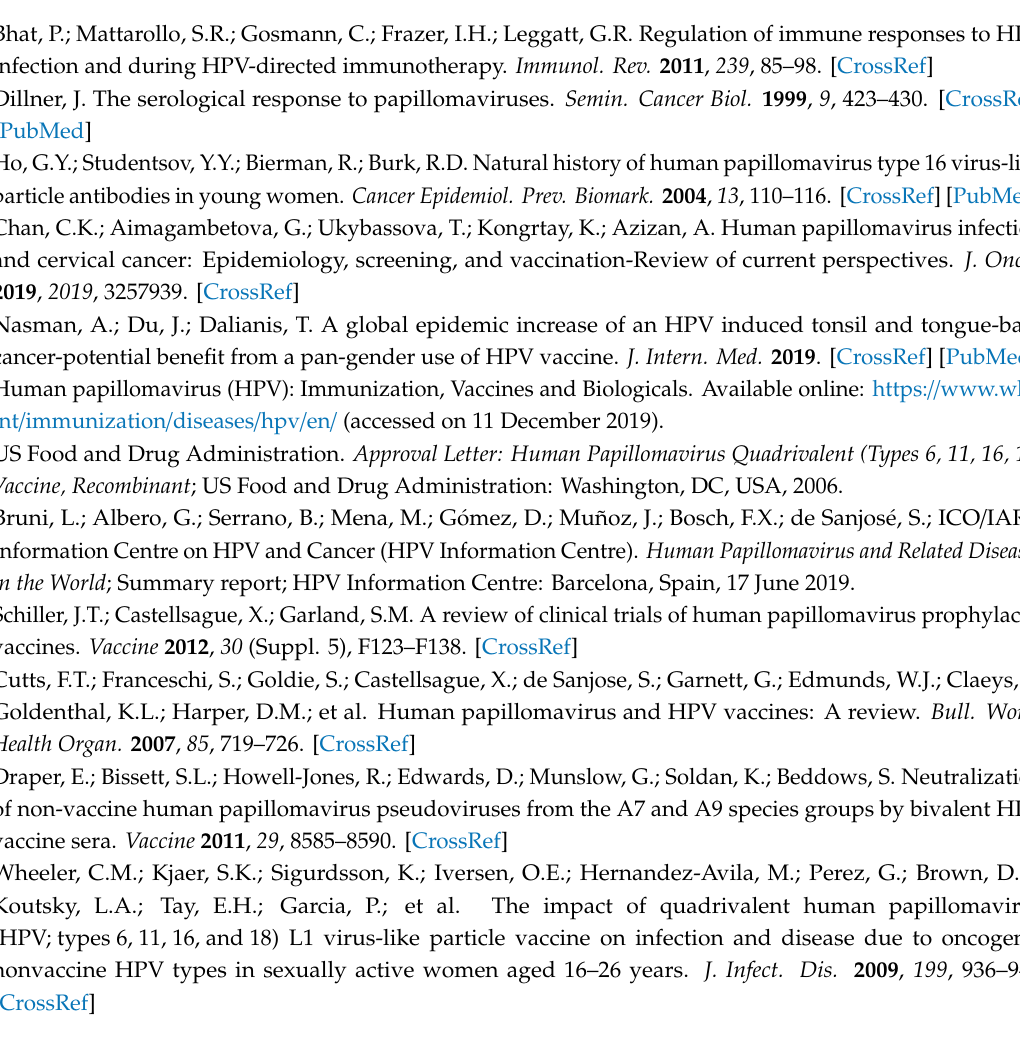
Figure S1: B cell Elispot protocol optimization, Figure S2: HPV-31 and HPV-45 cross-nAbs, Figure S3: HPV-6 and HPV-11 specific IgG and memory B cells in Gardasil vaccinated